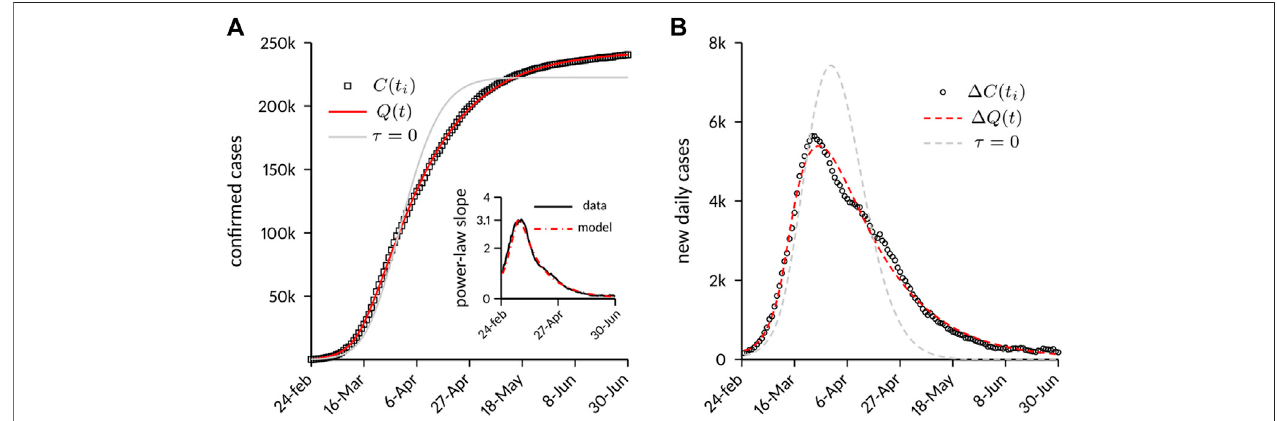
FIGURE 3 | Case numbers in Italy compared to model predictions. (A) Cumulative number of laboratory-con fi rmed infections. The model predictions are shown bothwiththefullmodelandwithavariantobtainedbysetting τ (cid:2) 0(constantdepletionrateofthesusceptiblepopulation).Theinsetreportsthelocalpower-lawslopefor the moving-averaged of fi cial data and the full-model prediction. (B) Number of new daily cases.